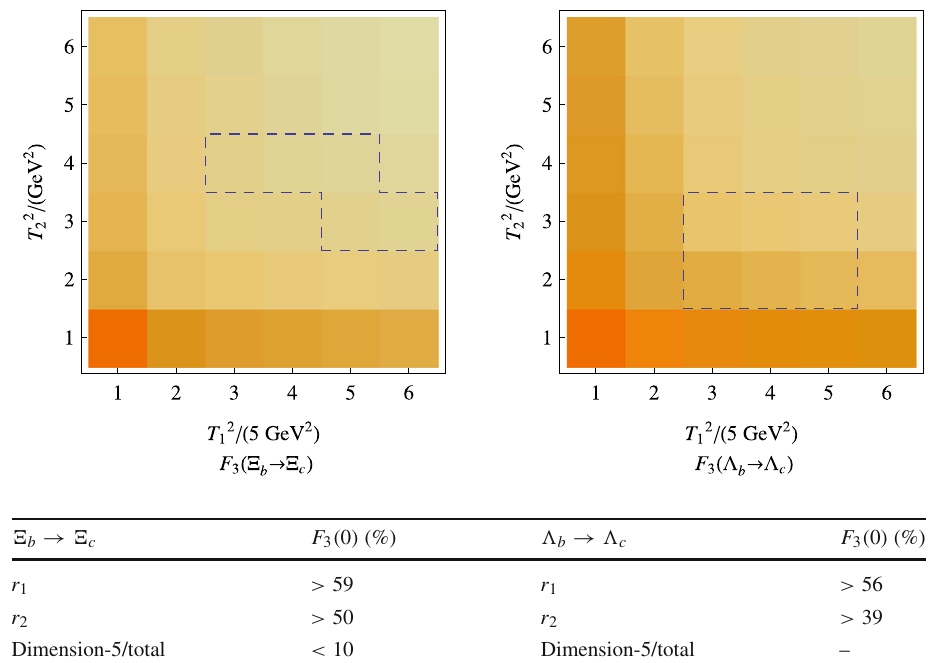
(cid:3) b → (cid:3) c Fig. 5 F (cid:2) b → (cid:2) c and F 3 3 at q 2 = 0 as functions of the Borel parameters T 2 and T 2 , 1 2 where T 2 and T 2 are taken as 1 2 free parameters. The larger the form factors, the darker the color. The preferred Borel regions are enclosed by the dashed contours